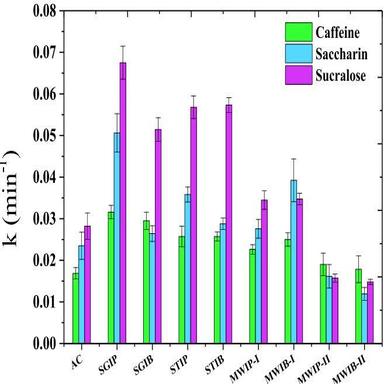
Values of the first-order kinetic constant (k, min− 1 ) of caffeine, saccharin, and sucralose removal under UV-C irradiation light using TiO2/AC heterostructures and pristine AC.